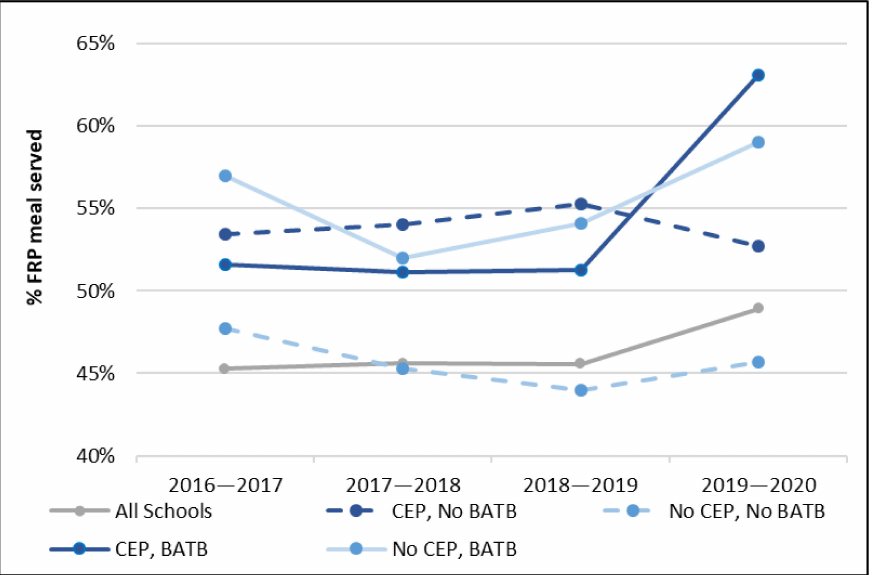
Figure 4. Annual change in breakfast program